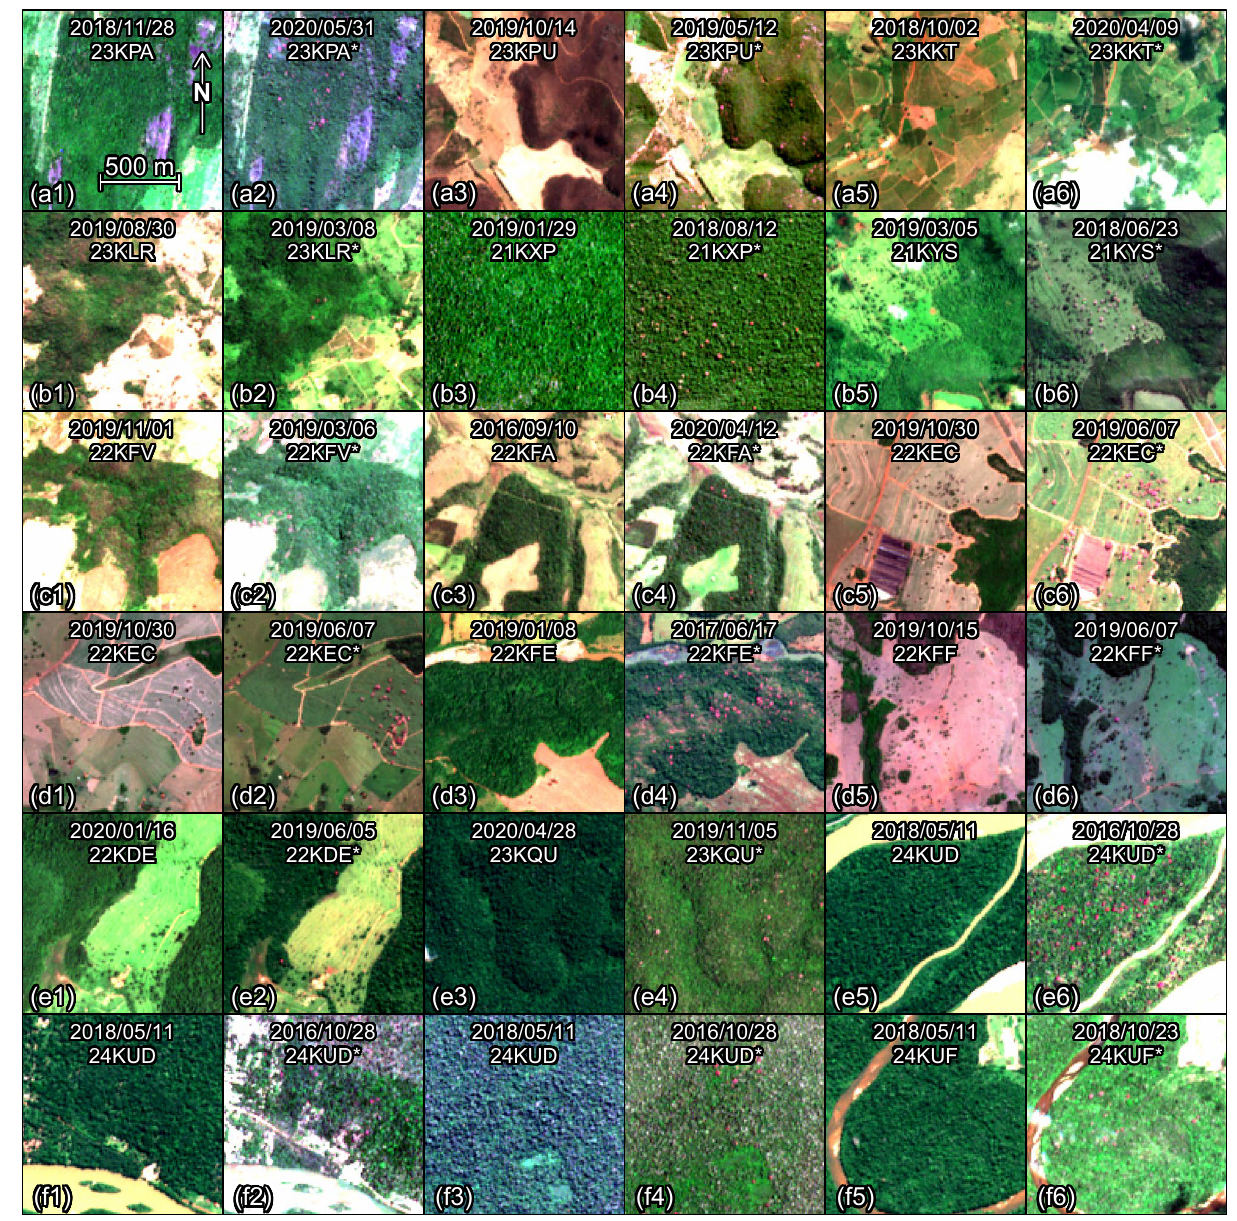
Figure 6. Sentinel-2 image subsets with Handroanthus trees detected by the model (Panel III). To ease the visual detection of the pink/magenta trees, one image taken outside the blossom period and one taken within the blossom period (denoted with an *) are given for each region of detection. The dates and tile names of the Sentinel-2 images are indicated on